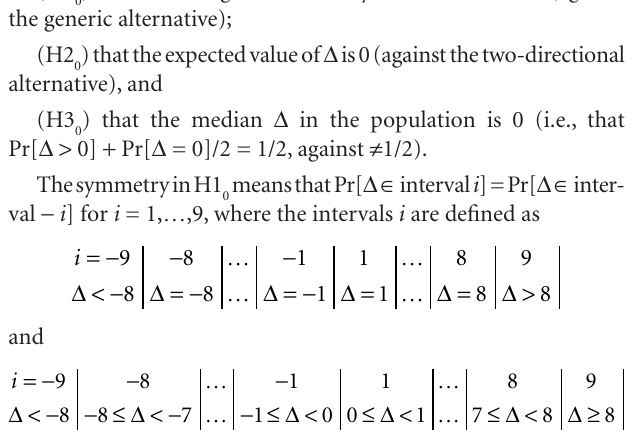
pixels (so the 1-pixel-wide bins are quasicontinuous representations grouped into the intervals between successive integers. The insets